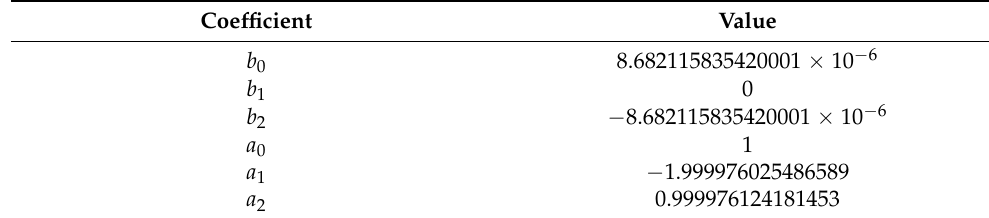
Table 3. The current loop PR resonant filter